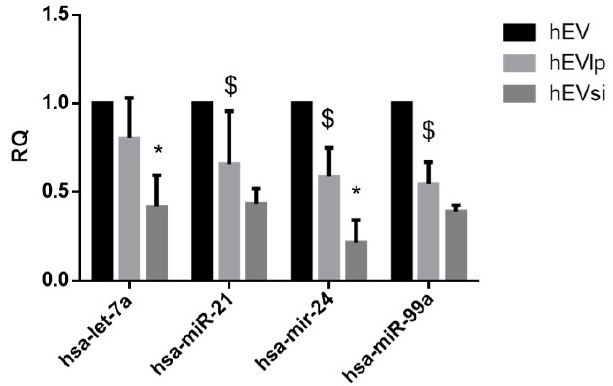
Figure 4. Characterization of RNA content of extracellular vesicles (EVs). Representative bioanalyzer profiles showing the size distribution of the total RNA extracted from ( A ) EVs obtained from naïve human mesenchymal stromal cells (hMSCs), i.e., hEVs, and EVs obtained from hMSCs transfected in the ( B ) absence (hEVlp) or ( C ) presence (hEVsi) of a CD73-specific small interfering RNA (siRNA). N = 3 samples analyzed with similar results. The first peak (left side of each panel) represents an internal standard. The EVs exhibit a relevant peak of small RNAs. EVs derived from MSCs are enriched in small RNAs [39,40]. The expression levels of some microRNAs (miRNAs) known to be enriched in EVs obtained from bone marrow- derived MSCs were evaluated using real-time polymerase chain reaction (PCR). As shown in Figure 5, the transfection procedure reduced the expression levels of the selected miRNAs. The presence of the CD73-specific siRNA further modified the expression levels of the selected miRNAs.